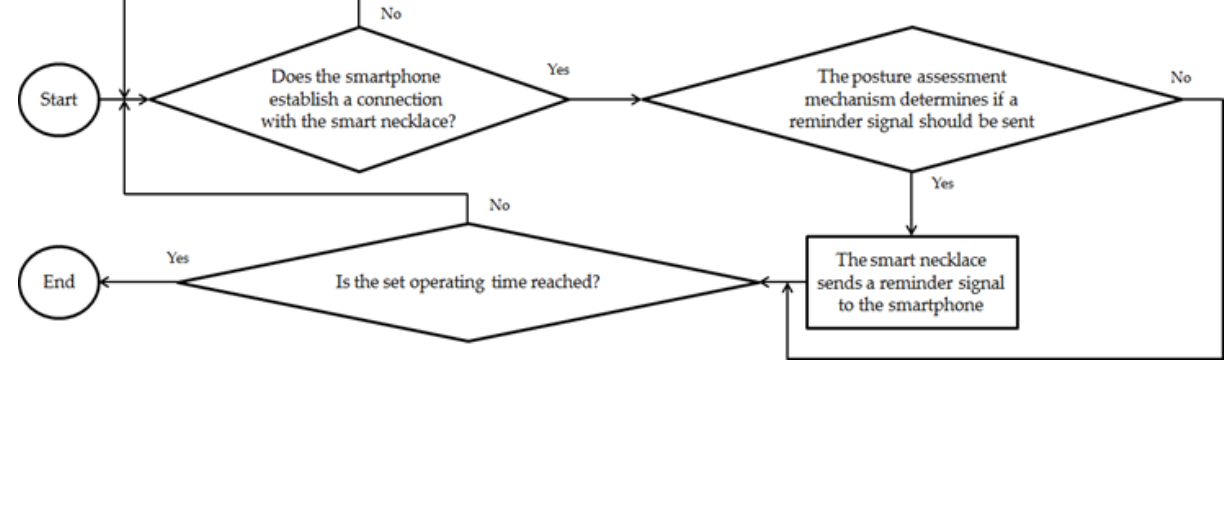
Figure 8. Flowchart describing the process whereby a reminder signal is sent from the smart necklace to the